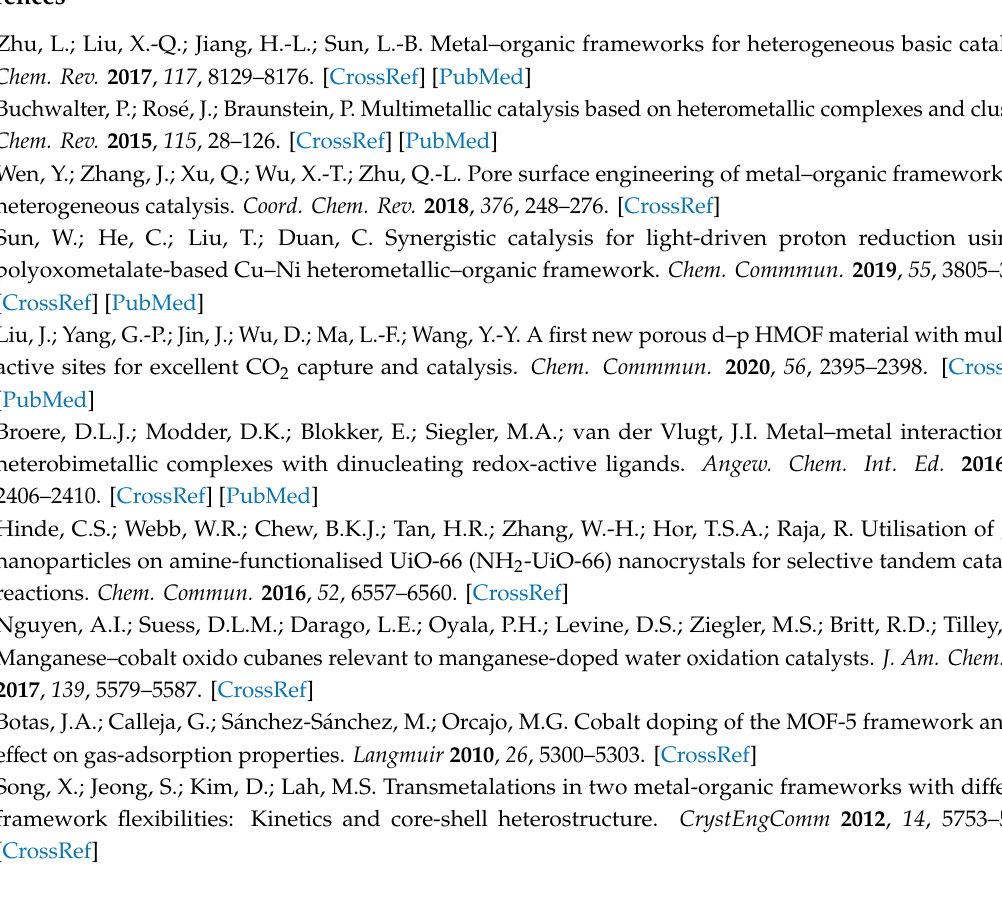
Supplementary Materials: Figure S1: The TGA curve of MOF 1 showing that the framework is stable up to ca. 100 ◦ C, followed by continuous weight loss and framework decomposition until ca. 650 ◦ C; Figure S2: The N 2 (77 K) sorption isotherms of MOF 1 with the black squares and red circles representing adsorption and desorption. P 0 is the saturated vapor pressure of the adsorbates at the measurement temperatures; Table S1: Selected bond distances in MOF 1 involving the Cd and Ca